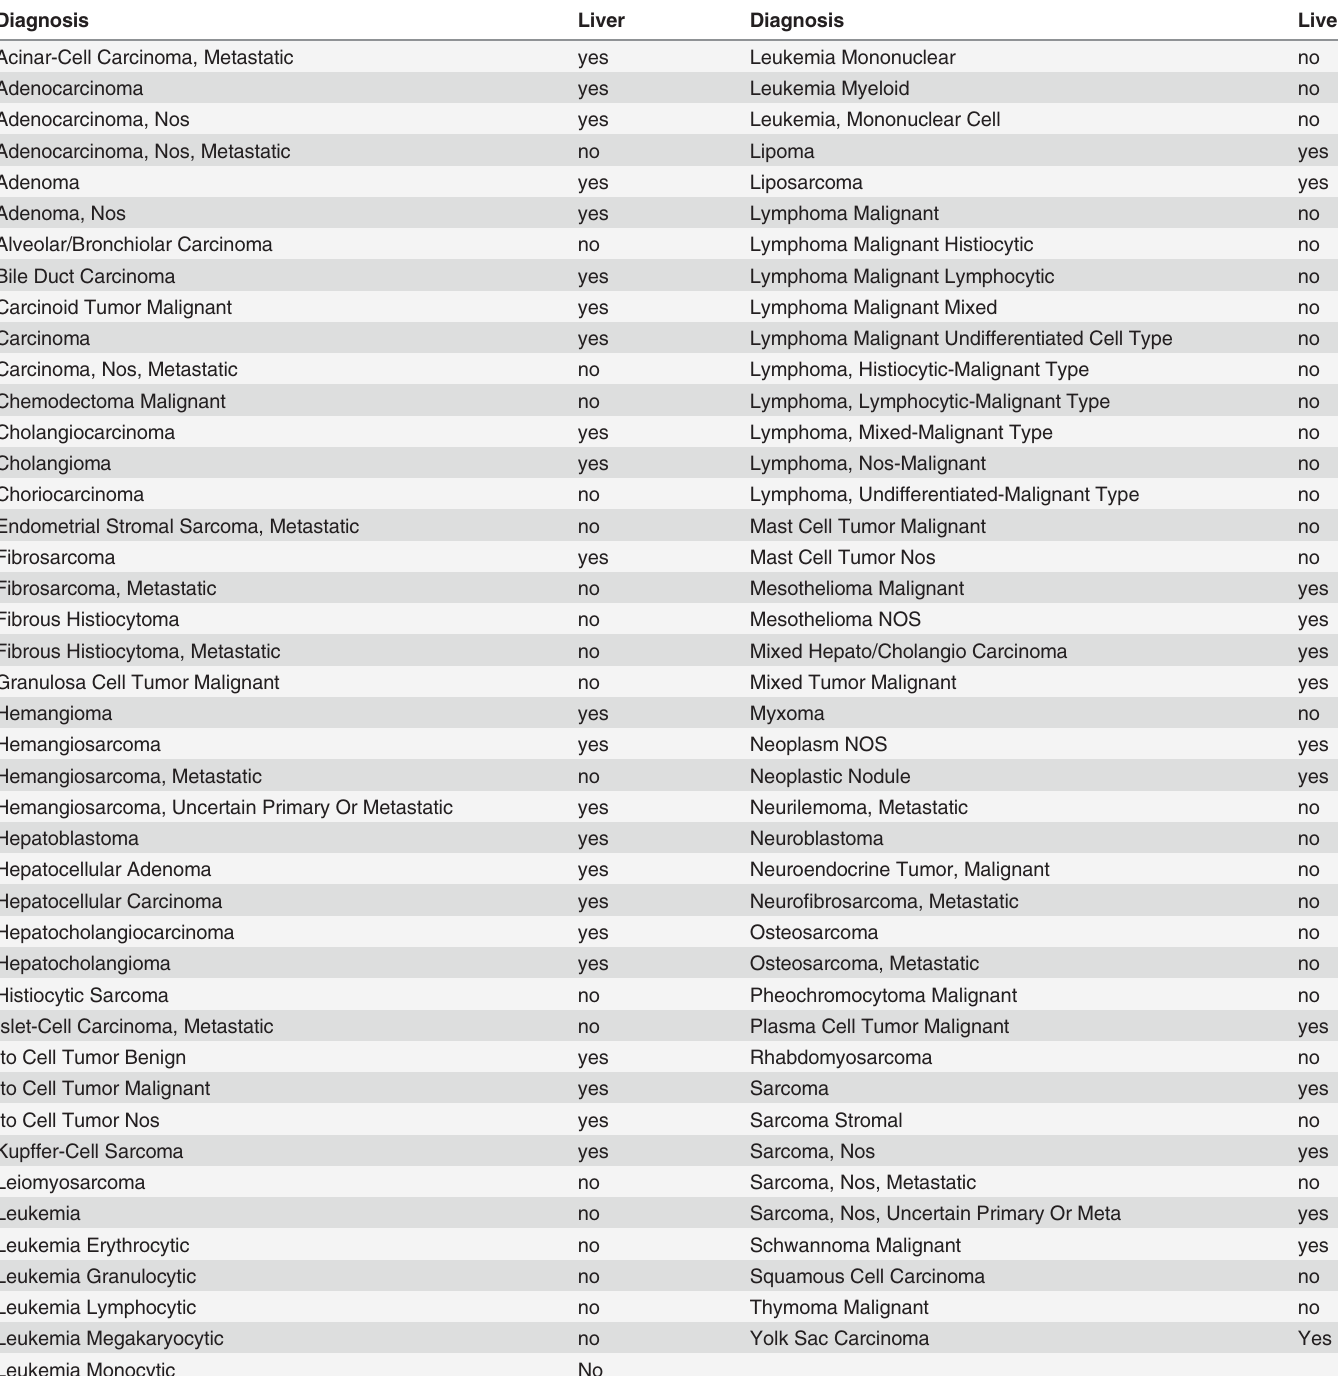
Table 4. Distinction between primary and non-primary liver tumors.